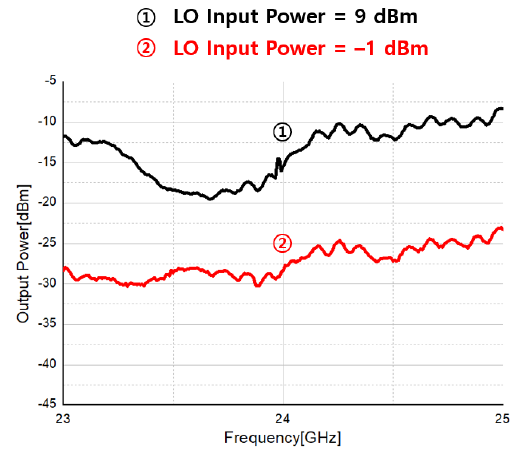
Figure 41. Measurement result of receiver LO leakage.